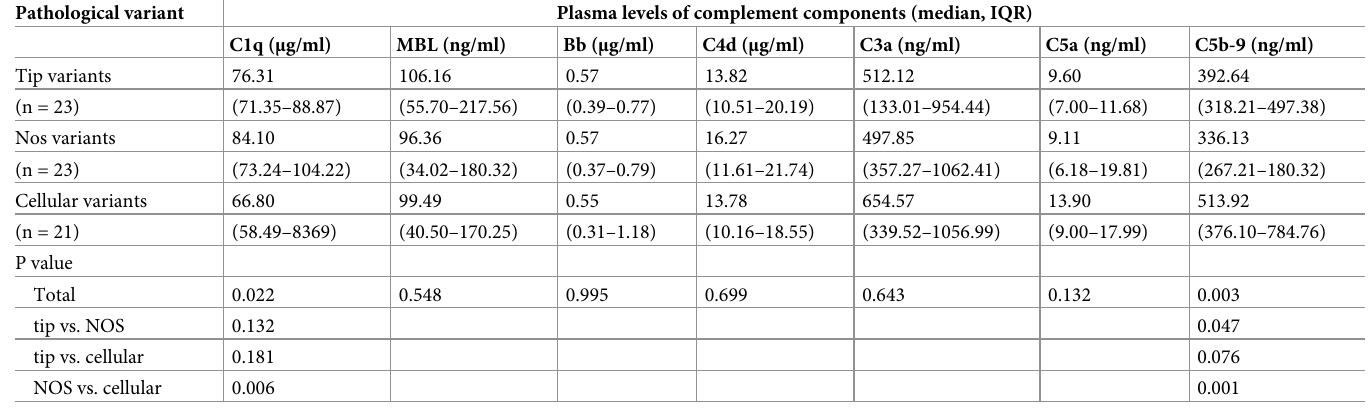
Table 2. Plasma levels of complement components in different pathological variants of primary FSGS patients. Pathological variant